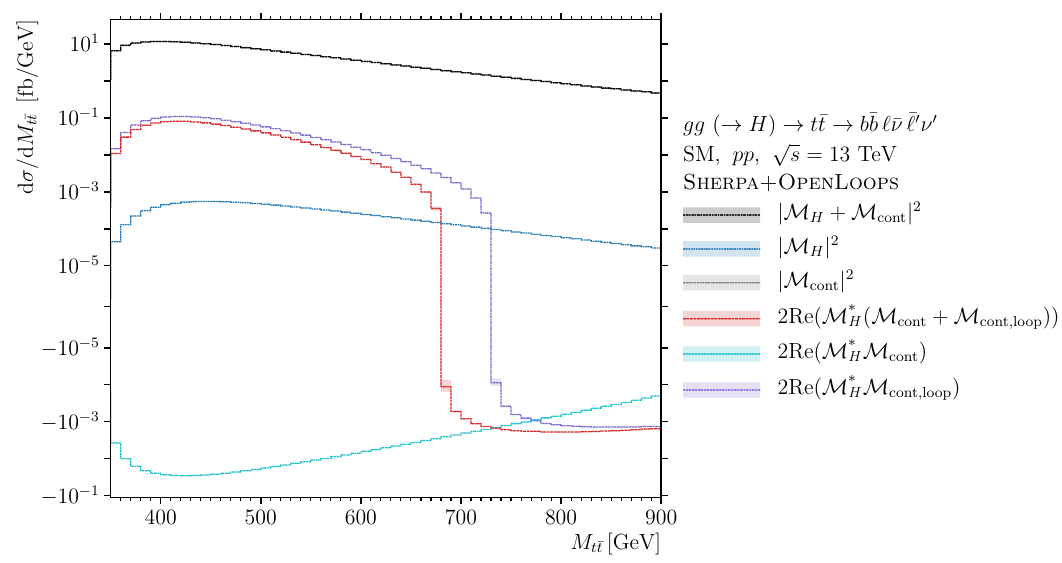
Figure 28 . M distributions for the process gg ( t ¯ t interference with the background in pp collisions at √ s = 13 TeV. Other details as in figure 4.